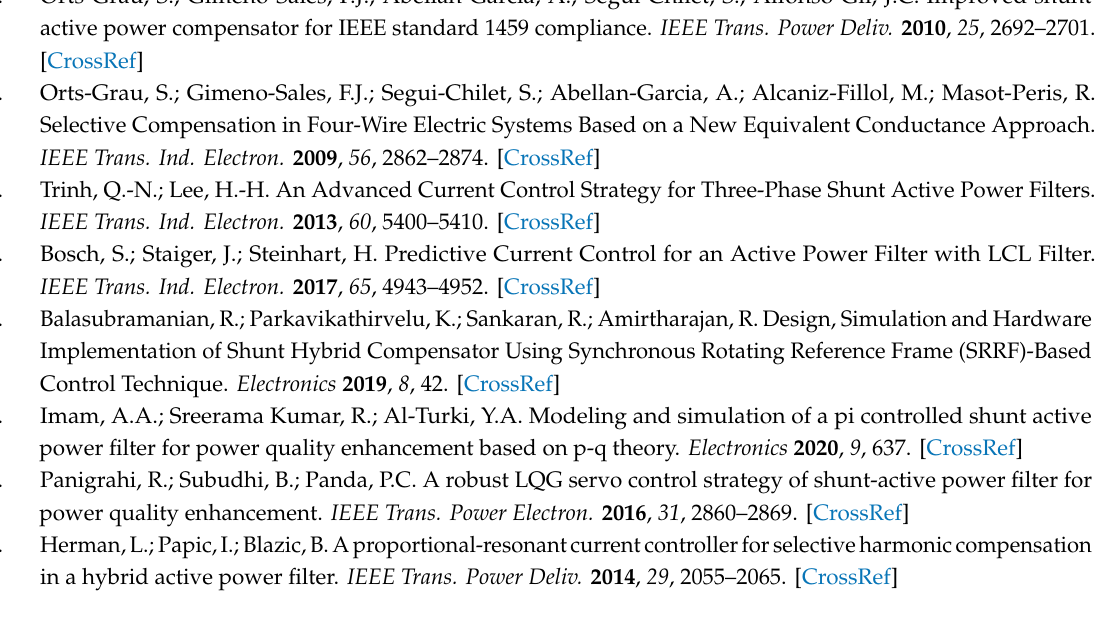
Figure 20. Supply currents during SAPF compensation.